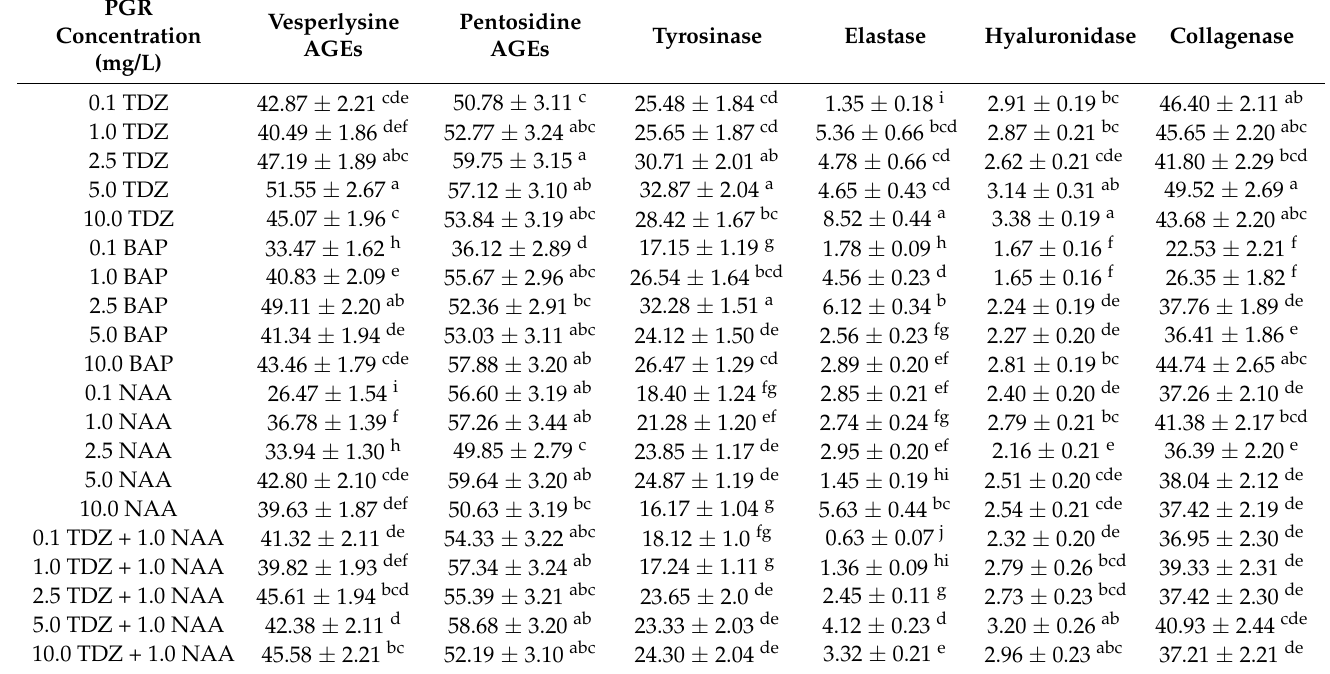
Table 5. Potential in vitro skin antiaging activities (expressed in % of inhibition) of the extracts of callus cultures of S. virginianum treated with different plant growth